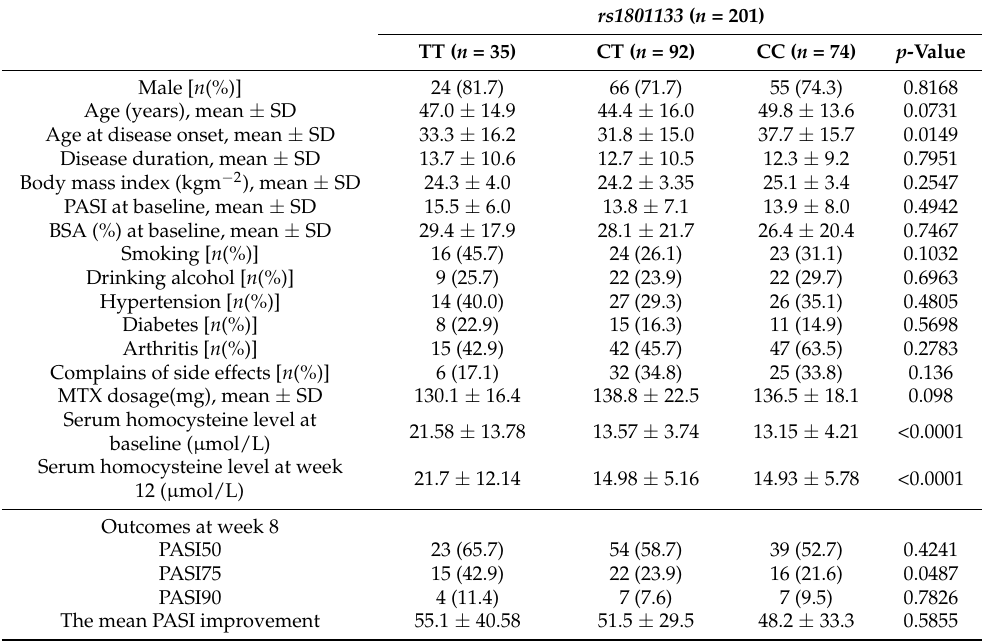
Table 1. The difference between clinical characteristics and serum homocysteine levels according to the genotype of MTHFR rs1801133 in 201 psoriatic